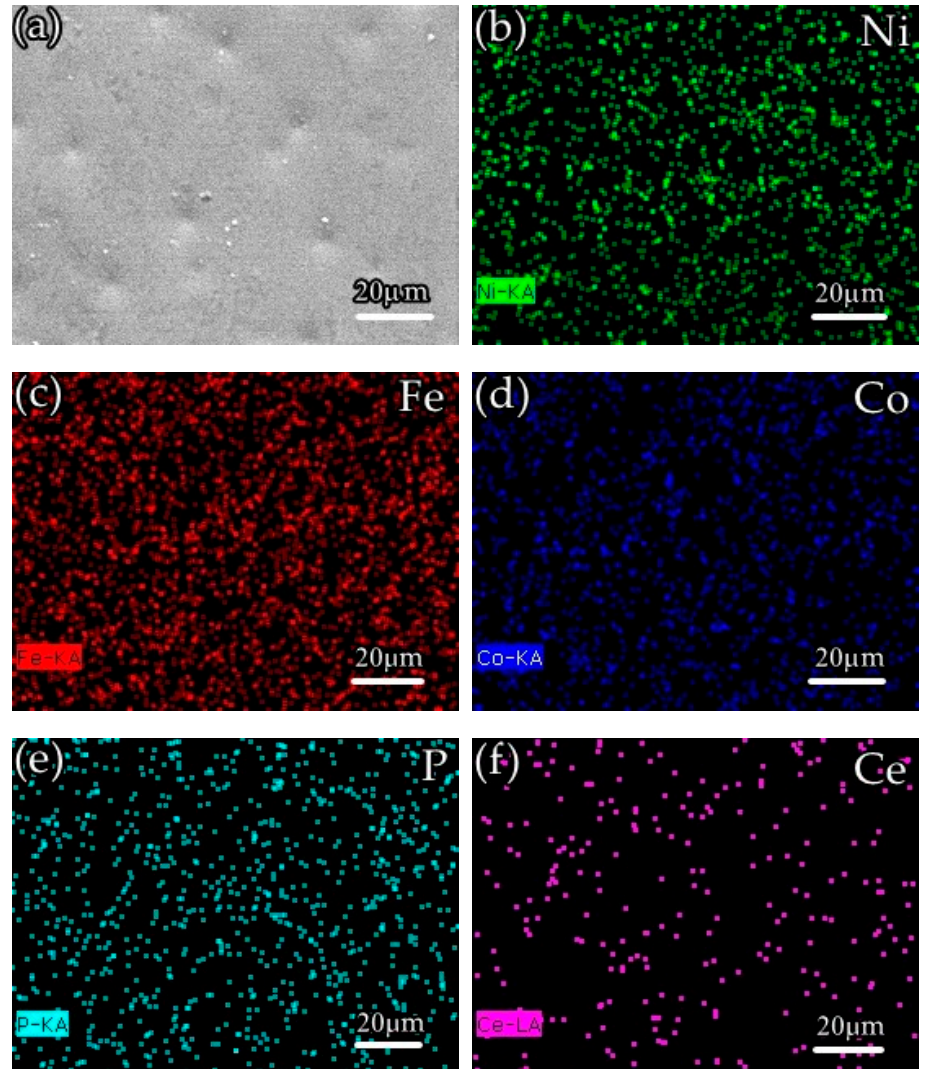
Figure 6. Elemental surface mapping of Ni-Fe-Co-P-1 g / L CeO 2 composite coating:( a ) the SEM image of the analyzed surface ( b ) Ni content; ( c ) Fe content; ( d ) Co content; ( e ) P content; and ( f ) Ce